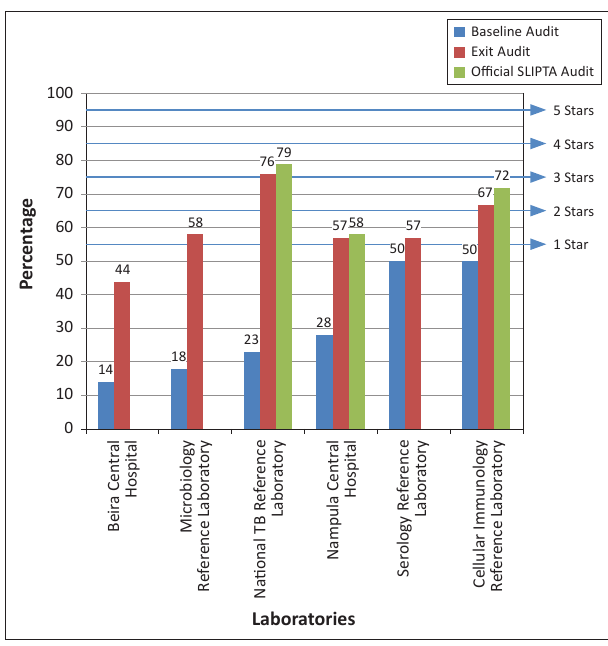
* Excludes two laboratories for which exit audit results were unavailable. SLMTA, Strengthening Laboratory Management Toward Accreditation; SLIPTA, Stepwise Laboratory Quality Improvement Program Towards Accreditation; TB, tuberculosis. FIGURE 2: Baseline, exit and official SLIPTA audit results and star ratings for the first cohort * of laboratories based on the SLIPTA checklist. Mozambique SLMTA programme, January 2011 to June 2013.